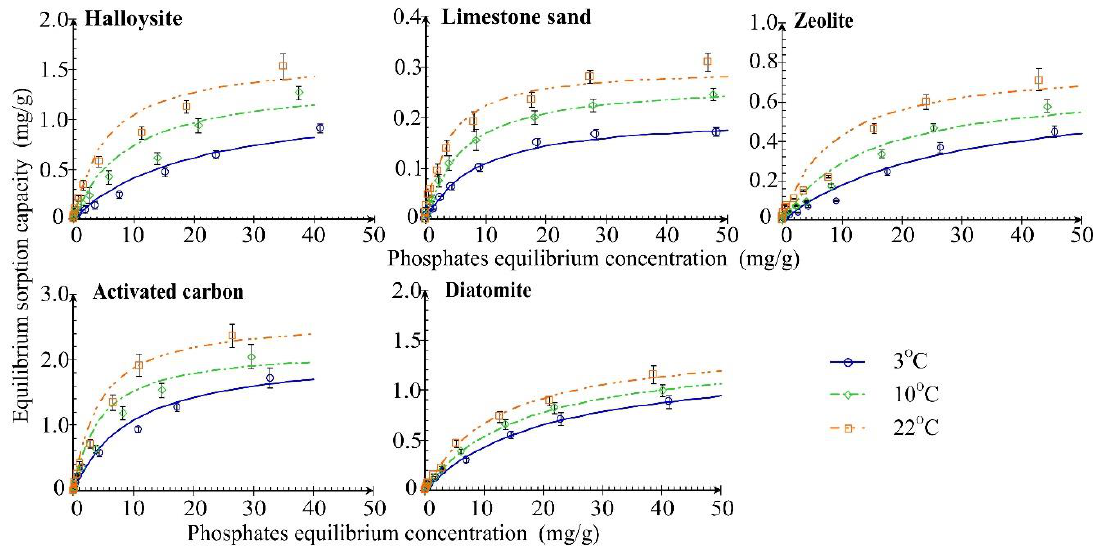
Figure 9. Adsorption isotherm of phosphates at 3 °C, 10 °C and 22 °C (error bars mark the standard deviation for n = 3; line—fitting of Langmuir isotherm).